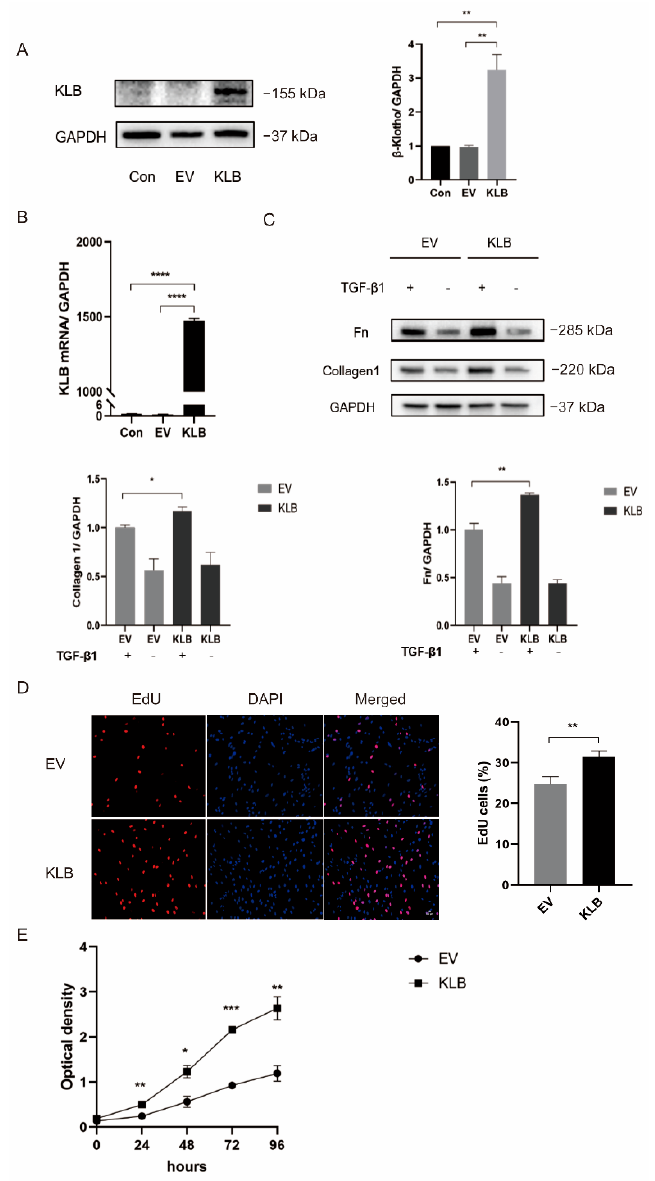
Figure 4. KLB can promote HESC fibrosis and cell proliferation. ( A , B ) Western blot and RT-qPCR analysis of KLB protein and mRNA levels in KLB-overexpressing ESCs. ( C ) Western blot showing that the expression of the fibrosis markers Collagen І and FN in the KLB overexpression group was significantly higher than that in the control group transfected with the empty plasmid under the same stimulation of TGF- β 1. ( D , E ) EdU and CCK8 assays showed that the overexpression of KLB promoted the proliferation of HESCs. * p < 0.05; ** p < 0.01; *** p ≤ 0.001; **** p ≤ 0.0001.